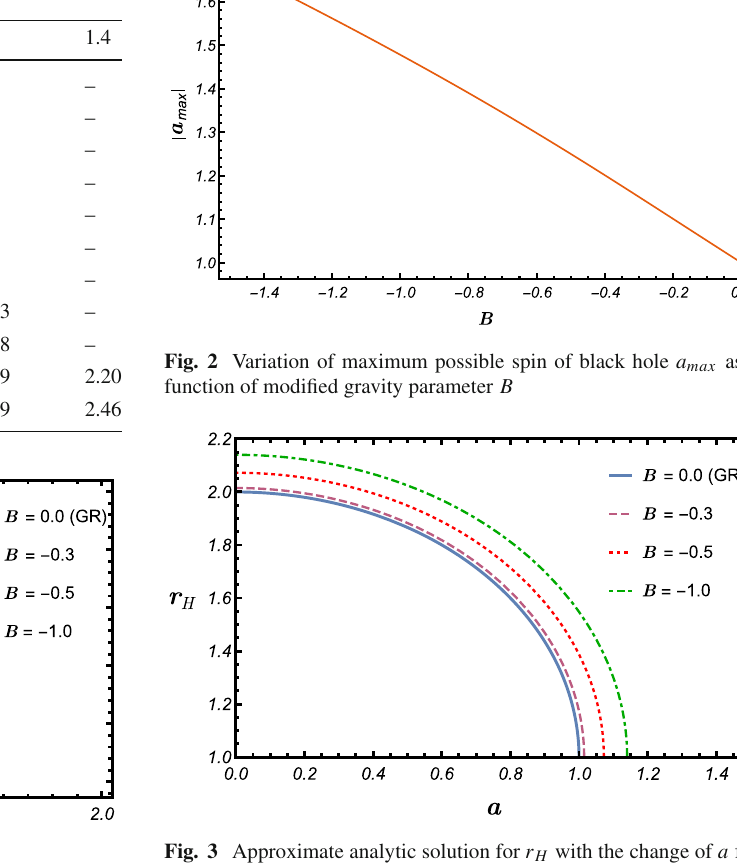
Fig. 3 Approximate analytic solution for r H with the change of a for different B surfaces of constant r